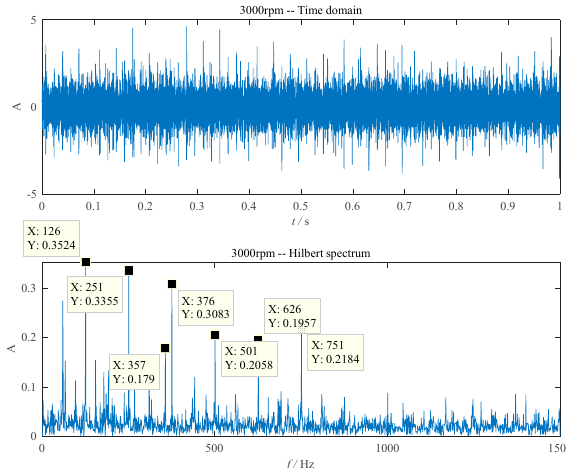
Figure 4. The ball–inner ring scratching fault. ( a ) The time domain waveform; ( b ) envelope detection based on improved EEMD.